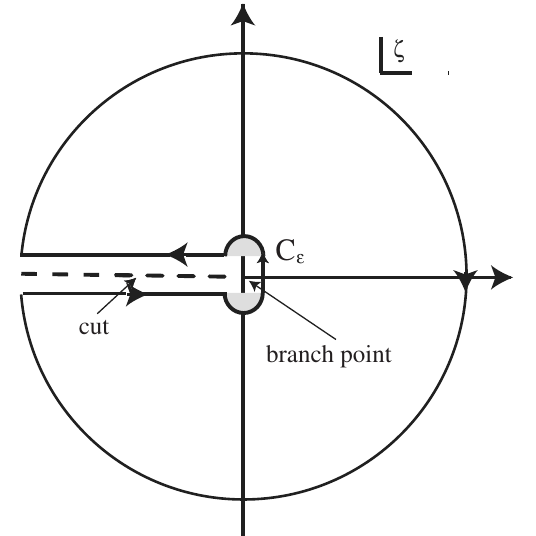
FIG. 10. The path of integration in Eq. (C6) in order to prove Eqs. (C3)–(C5). The horizontal and the vertical axes are the real and the imaginary axes,